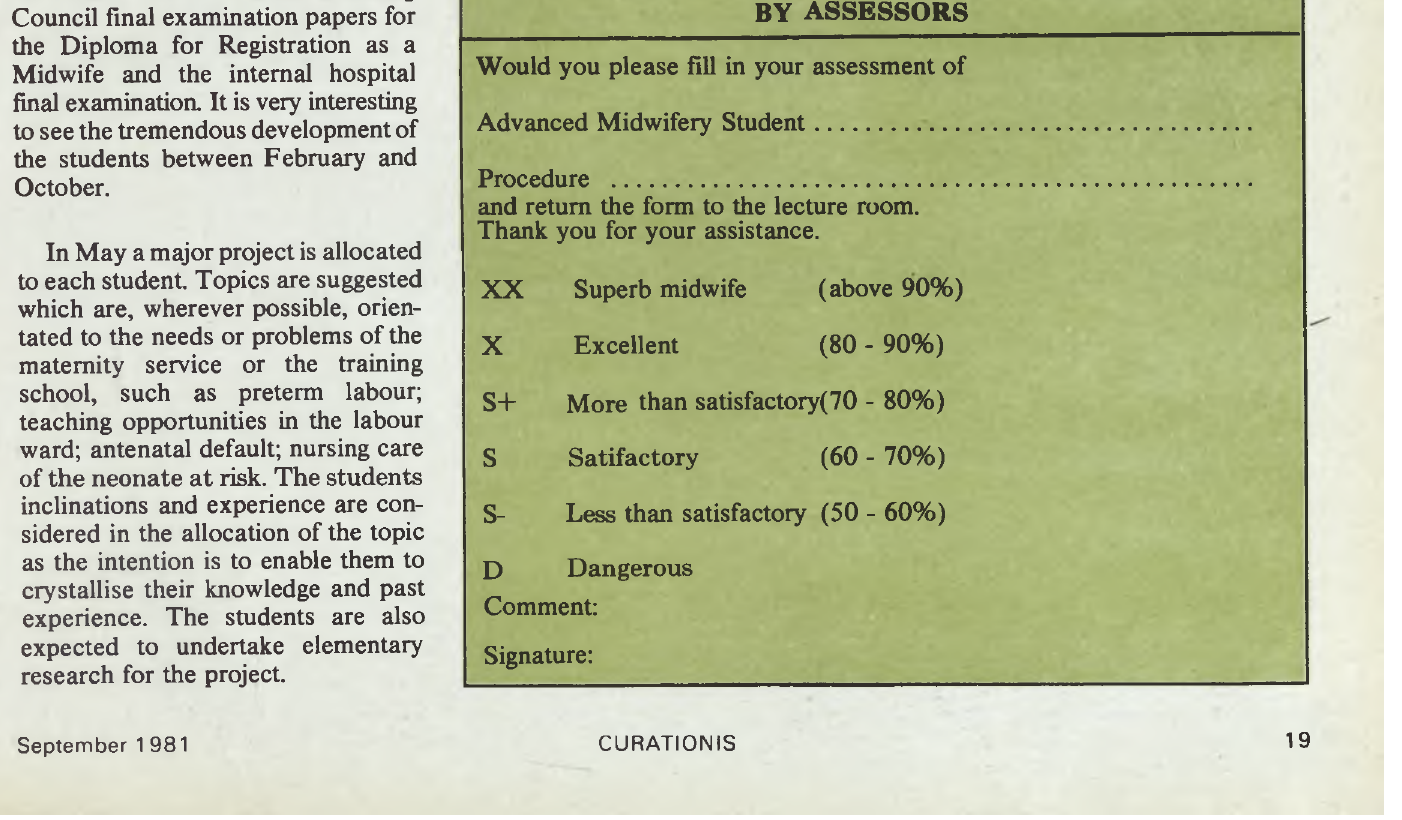
TABLE 3: ASSESSMENT FORM